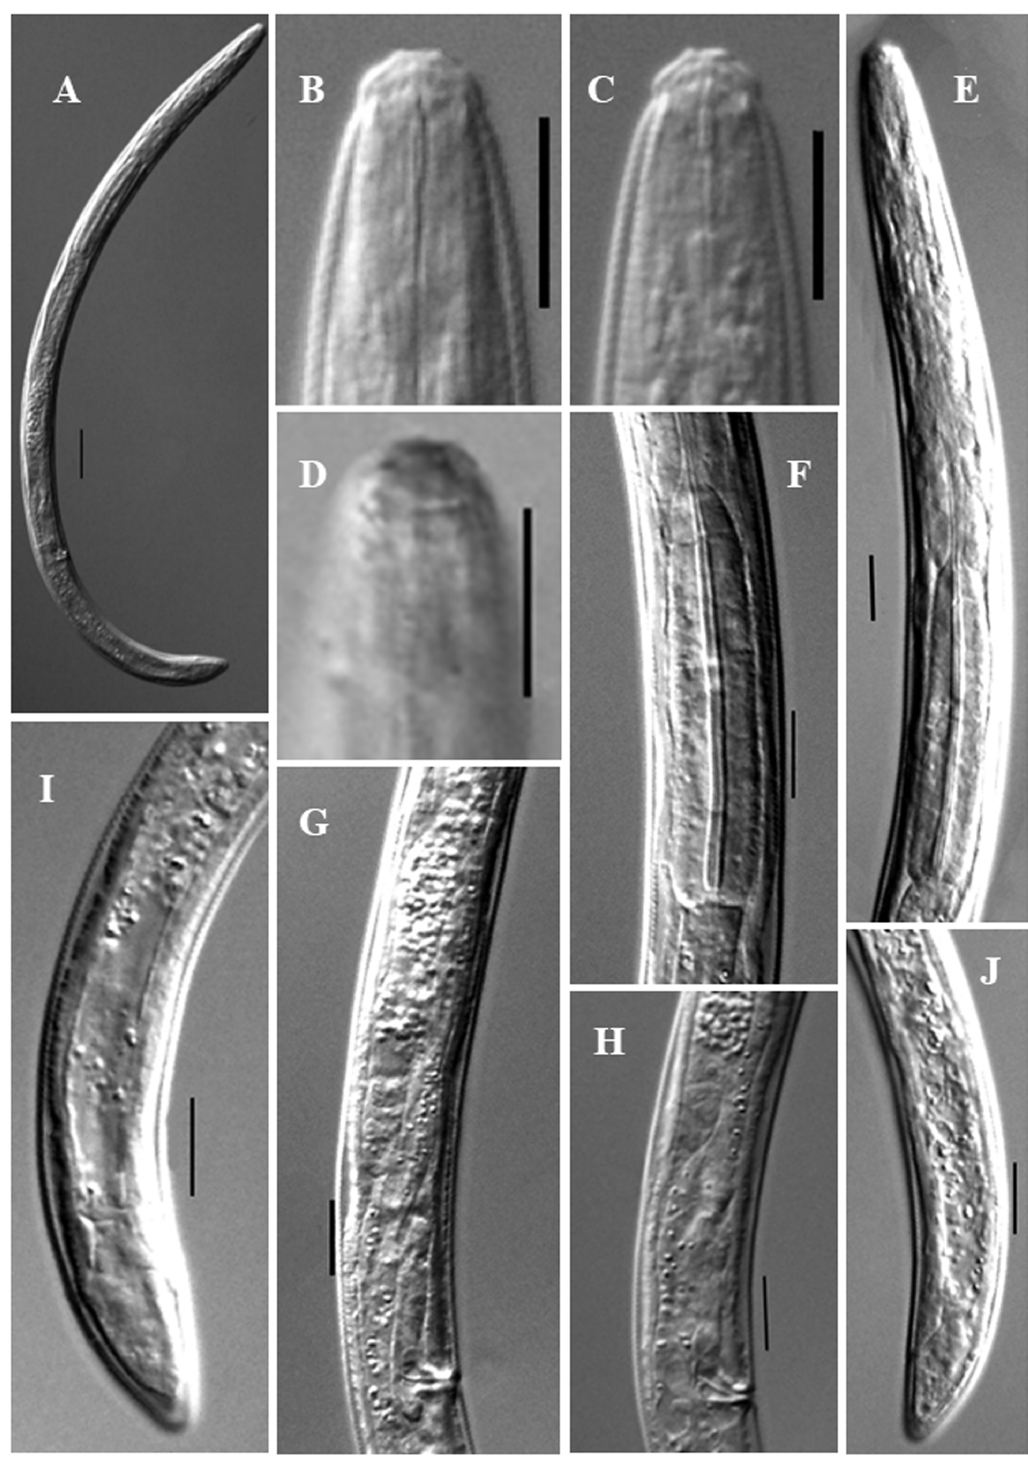
Fig. 14. Tylencholaimus striatus sp. nov., ♀ (LM photographs). A, C, I . Paratype 1 (slide 2). B, H . Holotype (AMU/ZD/NC/ Tylencholaimus striatus /1). D . Paratype 2, (slide 2). E, G . Paratype 5 (slide 4). F . Paratype 3 (slide 3). J . Paratype 4, (slide 3). A . Entire specimen. B–C . Anterior region. D . Anterior region showing amphid. E . Pharyngeal region. F . Expanded part of pharynx. G–H . Genital system. I–J . Posterior region. Scale bars: A = 20 μm; B–J = 10